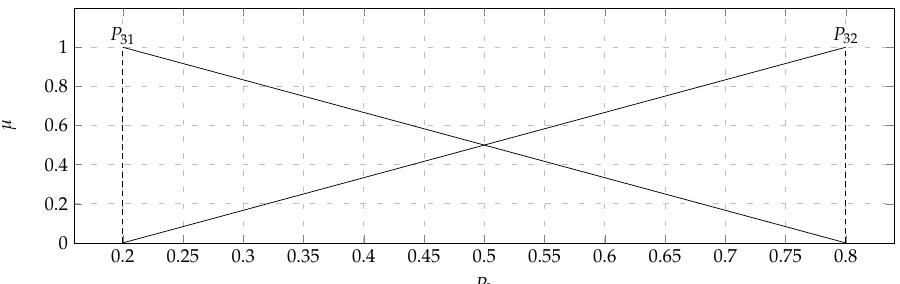
Figure 18. Visualization of Failures per round assessment model ( P 3 ) and triangular fuzzy numbers 0.2 ( P 31 ) and 0.8 ( P 32 ).